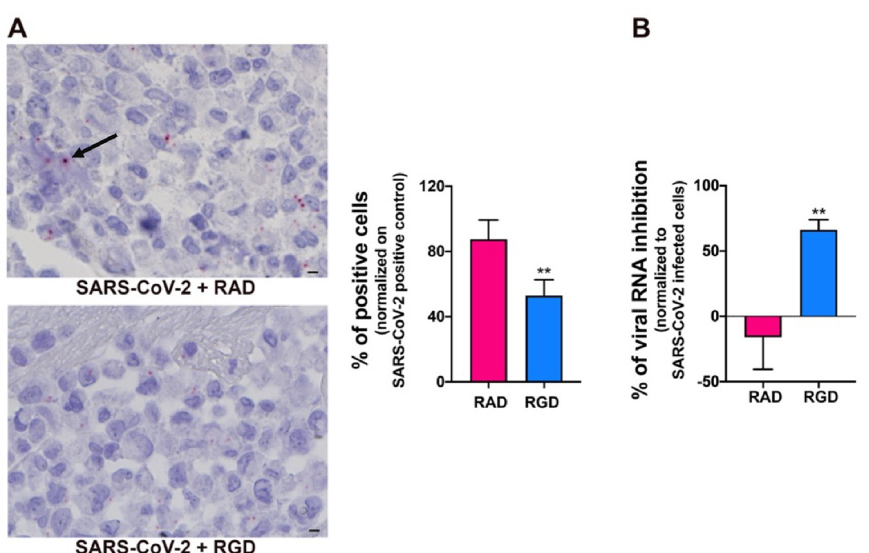
Figure 6. Integrins partially mediate SARS-CoV-2 infection of HL-mECs. HL-mECs were treated or not with RAD or RGD peptides before SARS-CoV-2 infection. ( A ) SARS-CoV-2 RNA in situ hybridization (black arrow) using the S antisense probe (scale bar, 3 µm). ( B ) Quantitation of SARS-CoV-2 genomes at the intracellular level by qRT-PCR. At least three replicates were performed. Data are representative of two independent experiments with similar results. Statistical analysis was performed by the Student’s two-tailed t -test (** p < 0.01).